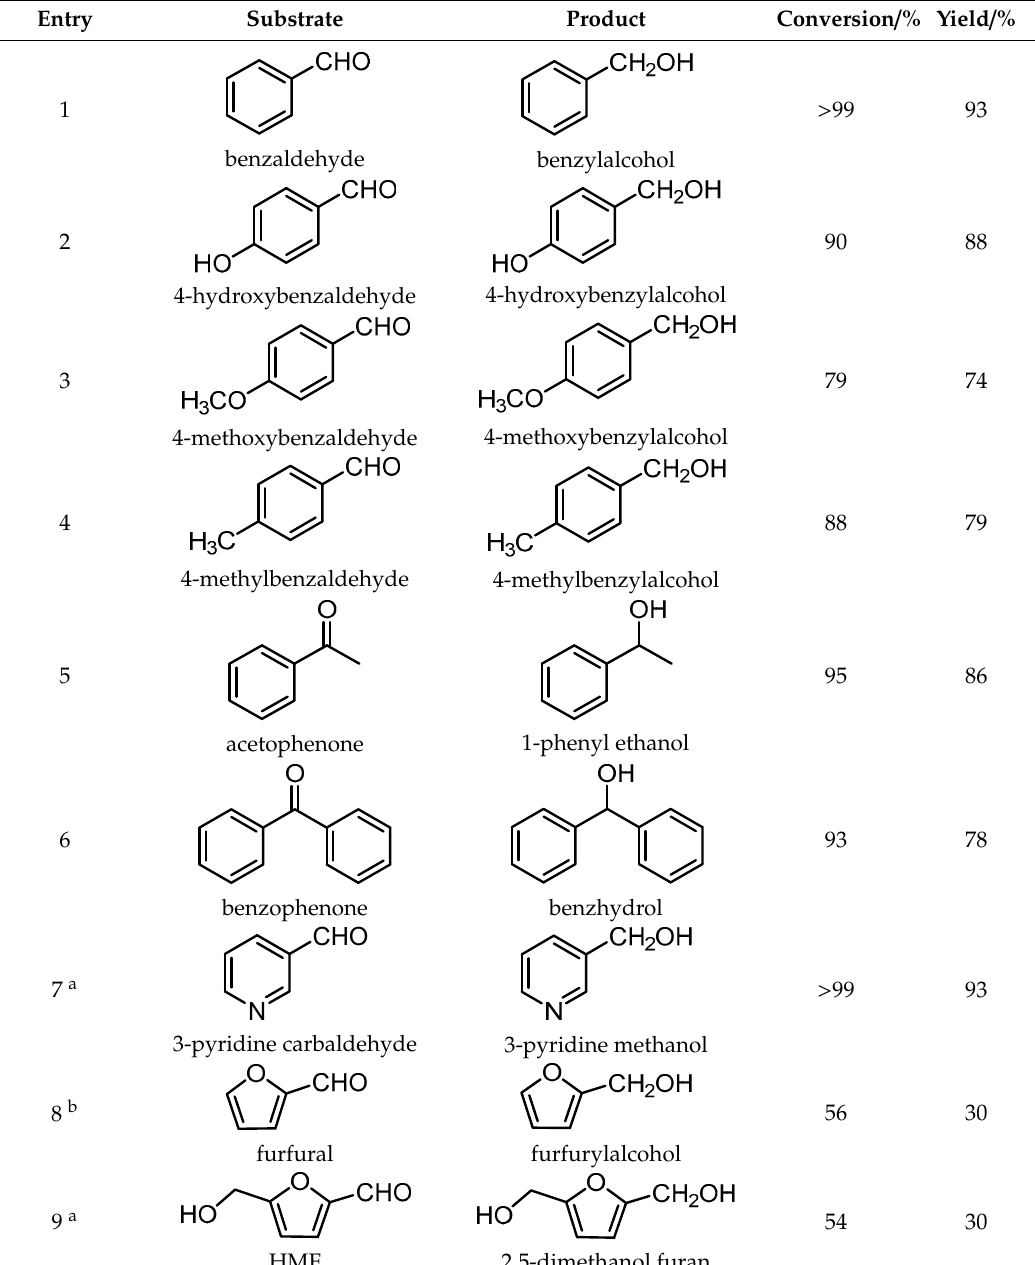
Table 3. Reduction of various alcohols with formic acid using a Pd/carbon catalyst.